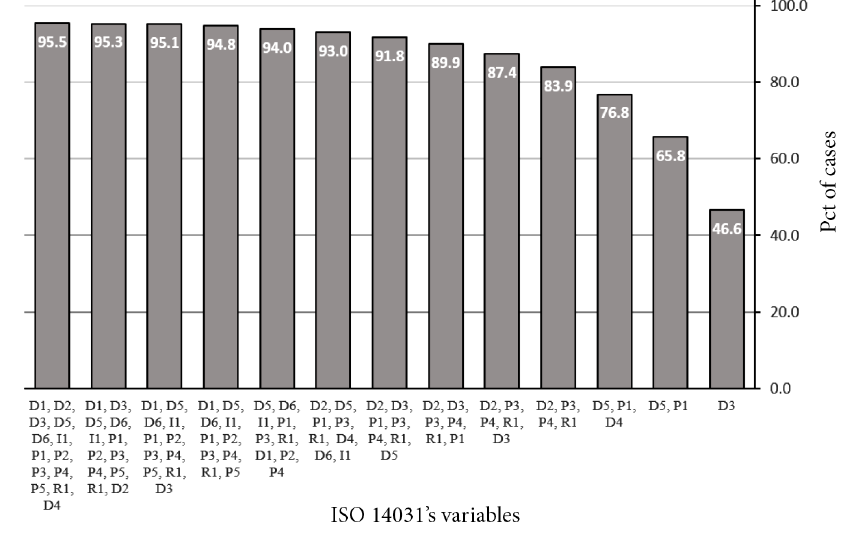
Figure 1. Best reach and frequency by group